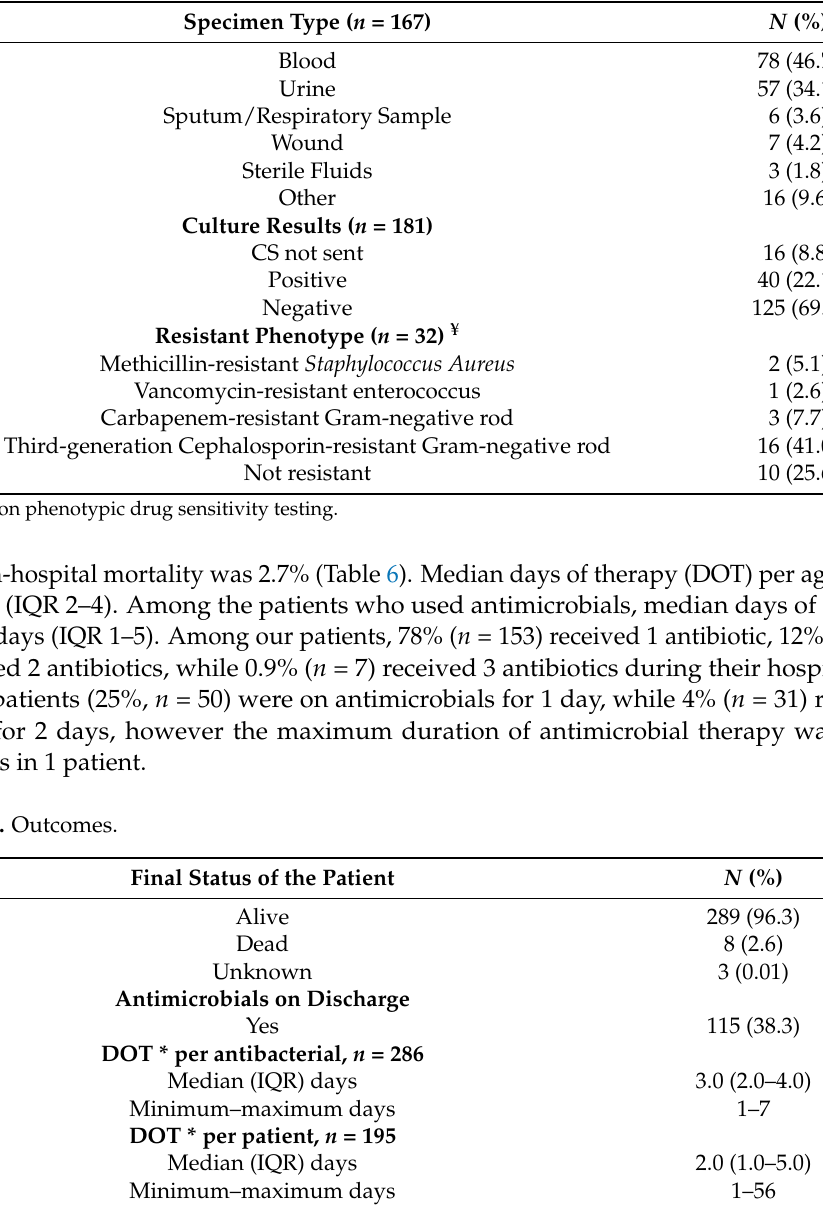
Table 5. Microbiological data.